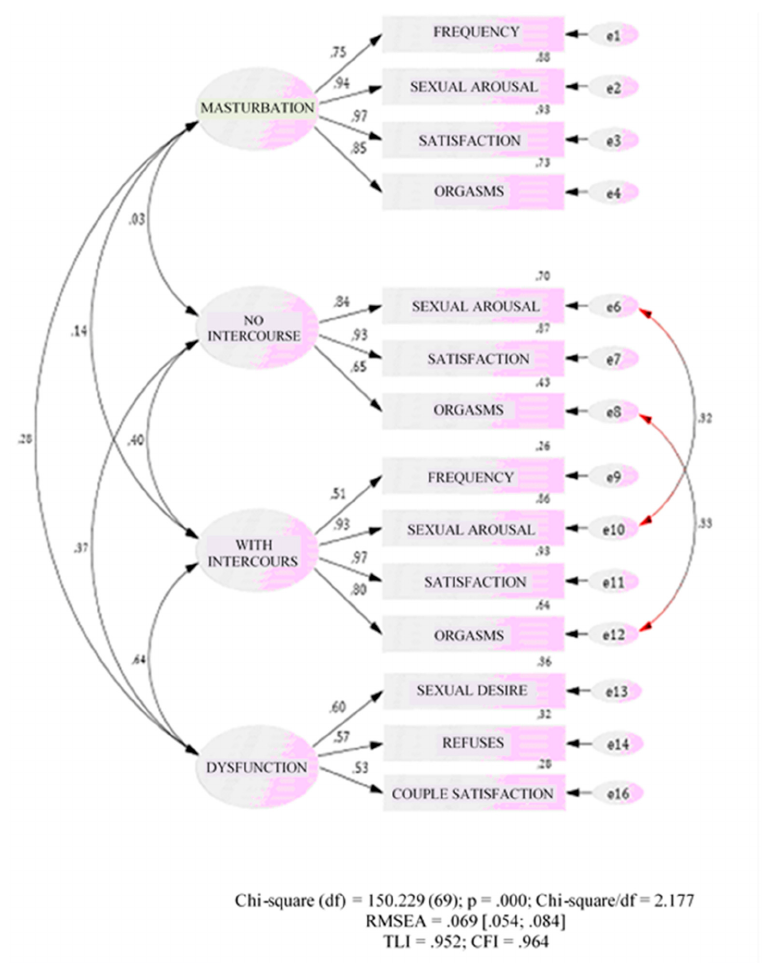
Figure A1. The path diagram. The model and the parameter estimates.